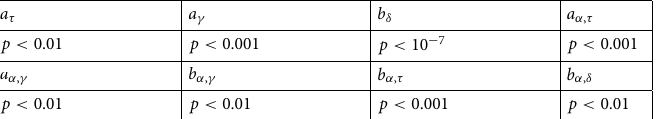
Table 5. Significant MsCr measures in Schizophrenia—balanced dataset. Discarding patients to balance sex between groups doesn’t affect overall pattern of results (compare to Table 4).